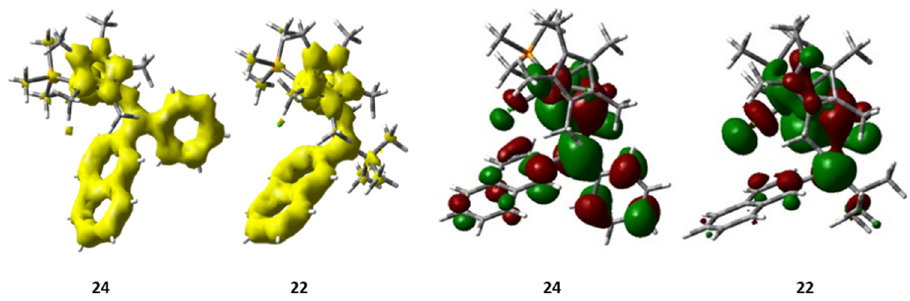
Figure 1. ACID representations (left) and LUMO orbitals (right) of complexes 22 and 24